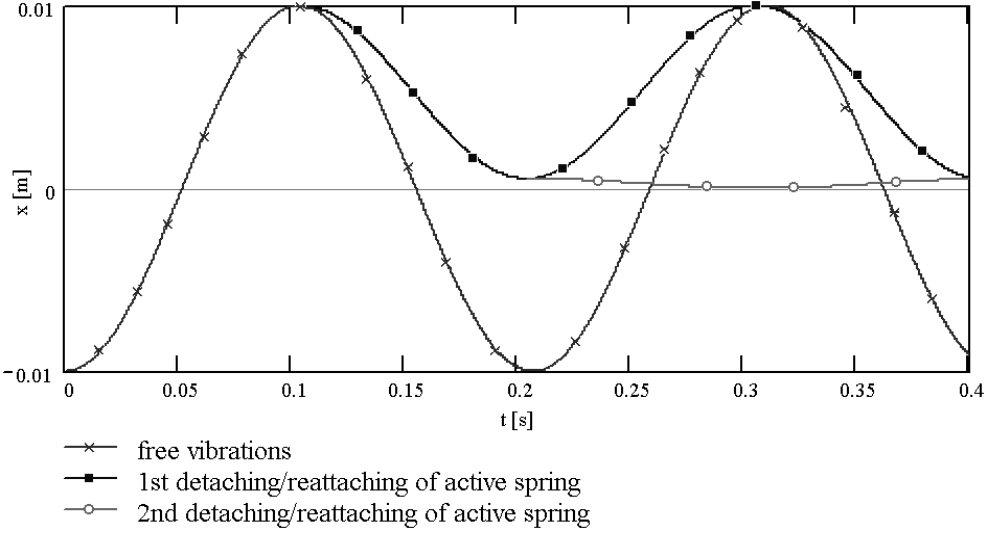
Fig. 2. Resulting mass displacement; control triggered twice.